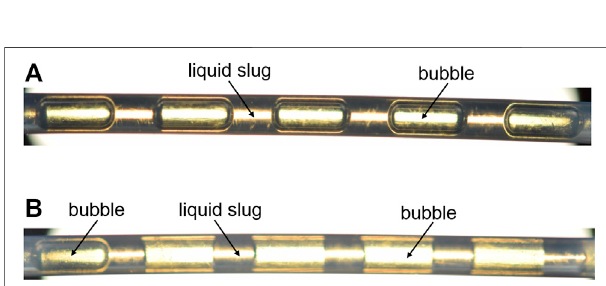
FIGURE6| PicturesofN 2 -waterslug fl owat fi rst (A) andafterca.30 min (B) in the PTFE microchannel ( d c (cid:1) 1.0 mm) previously used in the N 2 – TiO 2 / H 2 O fl ow experiments. Q g (cid:1) 2.77 ml/min, Q w (cid:1) 1.5 ml/min, the fl ow direction is from left to